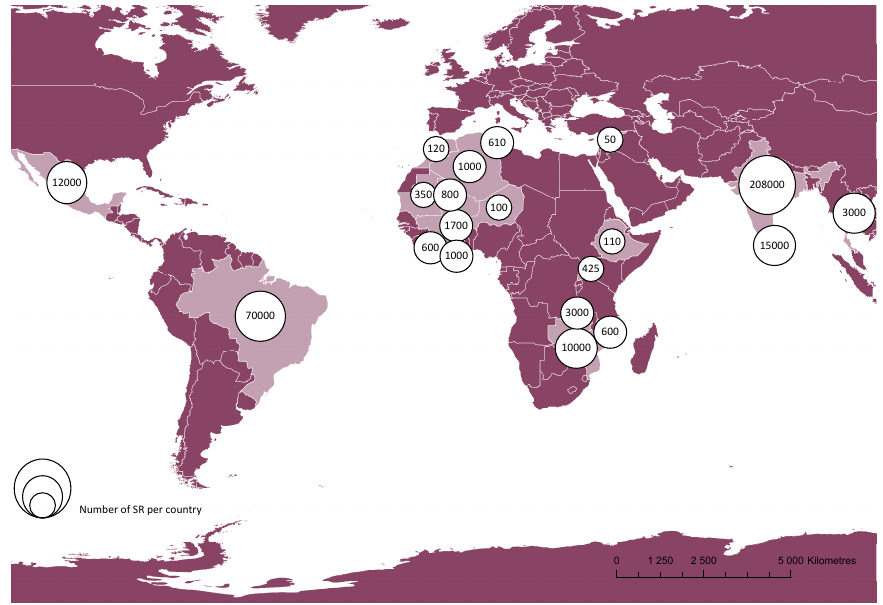
Figure 1. Estimated number of small reservoirs (SR) for several countries (based on national, non-exhaustive assessments in